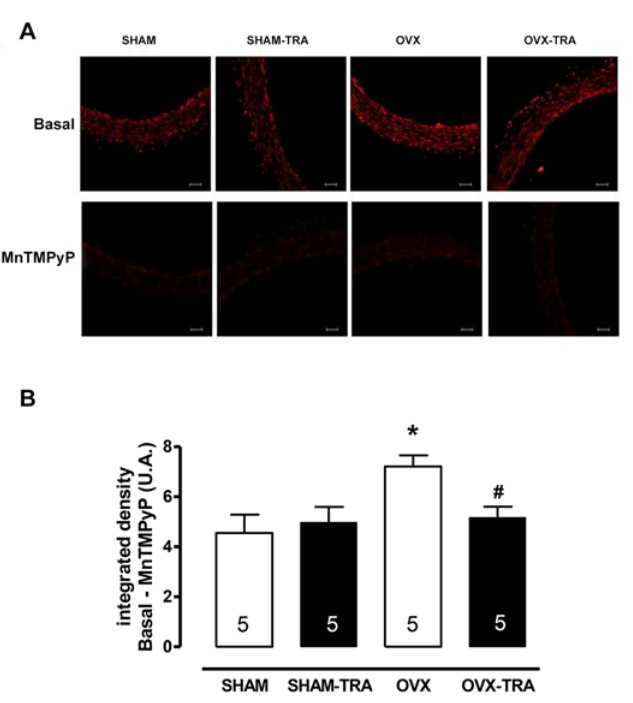
Fig 4. Representative images of aortic slices from SHAM, SHAM-TRA, OVX and OVX-TRA rats, in the absence (upper panel) and presence (lower panel) of the superoxide dismutase mimetic, MnTMPyP (A). Quantification of fluorescence intensity emitted by DHE oxidation in aortic slices in the absence and presence of the MnTMPyP as an indicative of reactive oxygen species in SHAM, SHAM-TRA, OVX and OVX-TRA rats (B). The numbers shown in bars represent the number of animals analyzed in each group. Results are expressed as means ± SEM. Two-way ANOVA: * p < 0.01 in comparison to SHAM, # p < 0.01 in comparison to OVX.